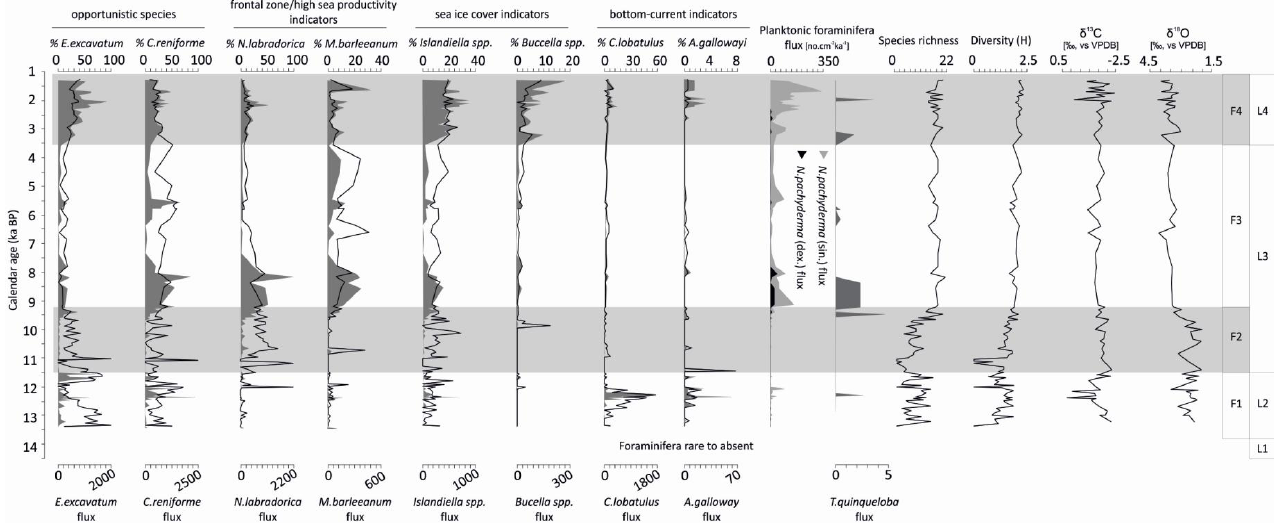
Figure 5. Percentage distributions (upper scale; black line) of the most dominant benthic species, fluxes (no. cm − 2 ka − 1 ; bottom scale; grey shading) of benthic and planktonic foraminiferal species, diversity parameters (species richness and Shannon–Wiener index) and stable oxygen and carbon isotope data ( δ 18 O and δ 13 C) plotted versus thousands of calendar years with indicated foraminiferal zonation (zones F1–F4) and lithostratigraphic units (L1–L4). Foraminiferal taxa are grouped based on their ecological tolerances described in the